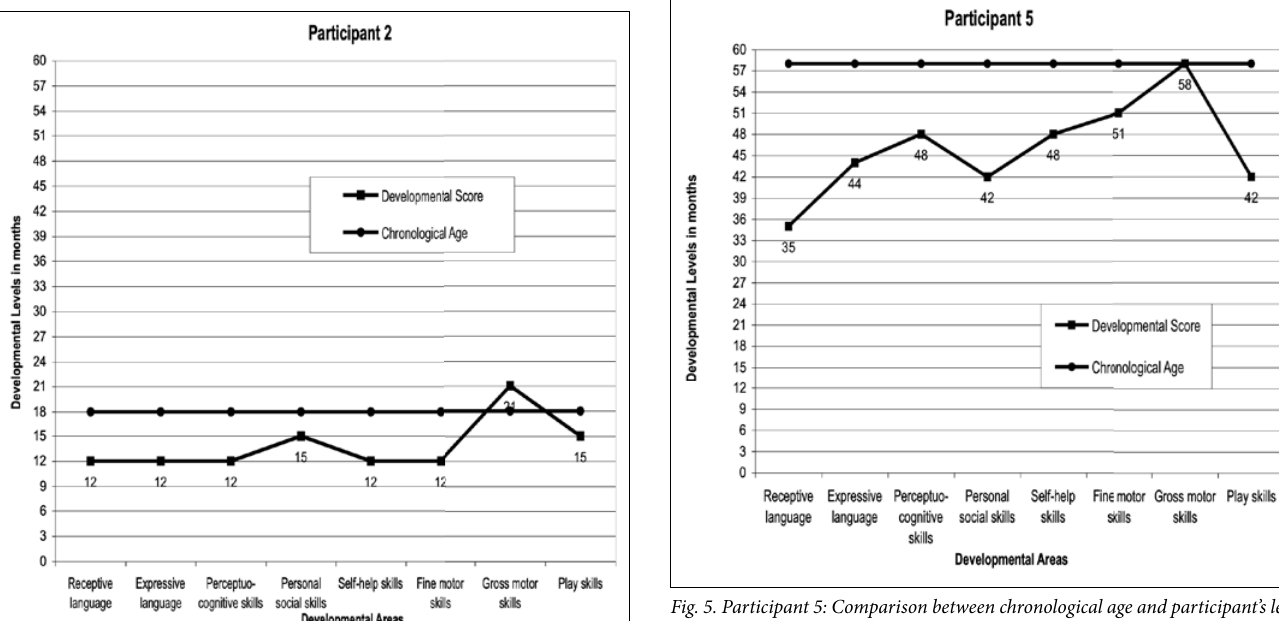
Fig. 1. Participant 1: Comparison between chronological age and developmental level of functioning.